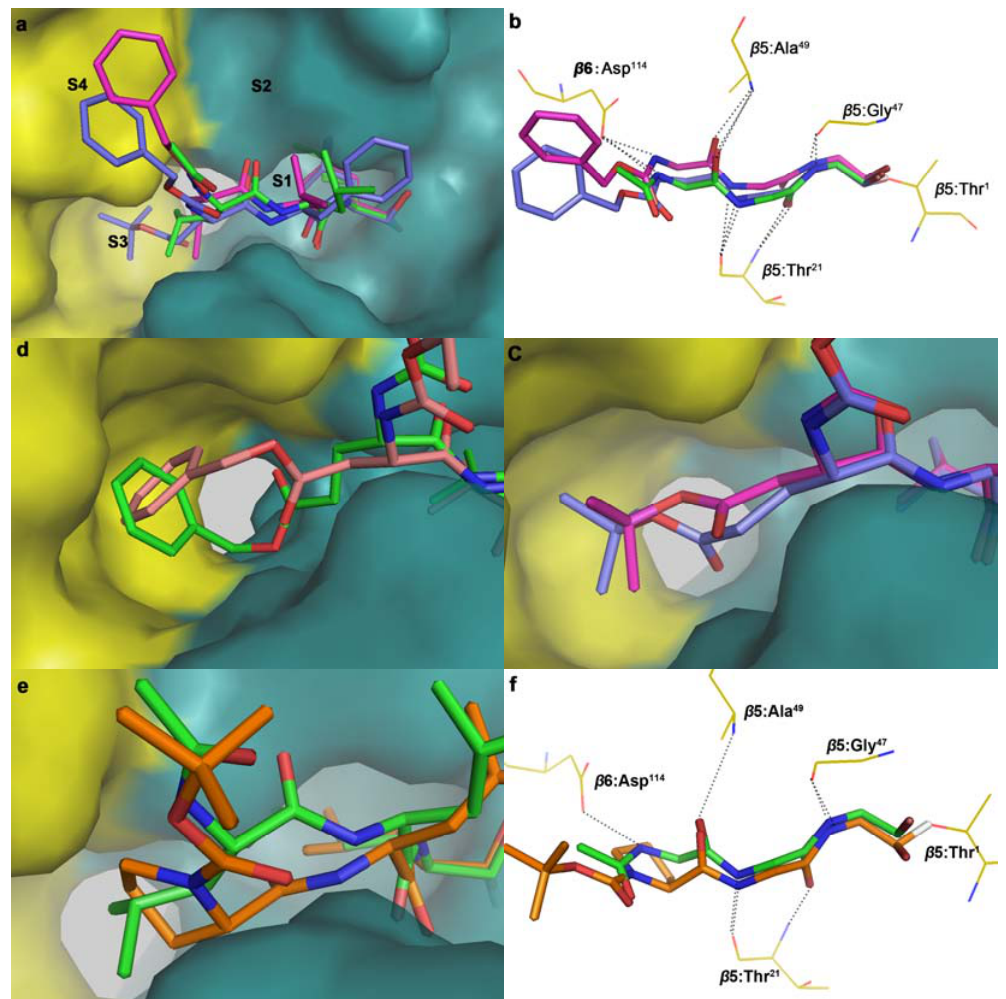
Figure 2. ( a ) Binding modes of 1 (green), 2 (magenta) and 3c (purple) with 20S proteasome. β 5 and β 6 subunits are shown in green and yellow, respectively. ( b ) The binding sites of proteasome and 1 (green), 2 (magenta) and 3c (purple). Only backbones and key residues of active sites are shown. ( c ) Binding modes of 3a which is shown in magenta and 3c in purple. The side chains at P3 position project into S3 pocket. ( d ) Binding modes of 3j ( pink) and 3l (green). The side chains at the P3 position project into S3 pocket. ( e ) Chymotryptic-like active site in binding modes with 1 (green) and 3m (orange). ( f ) Key contacts between residues of the ligand binding site of the 20S proteasome core particle and the backbones of 1 (green) and 3m